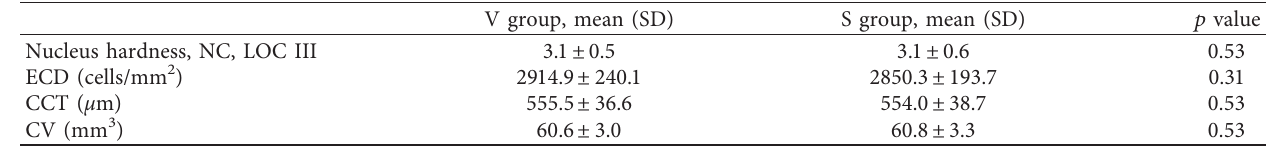
Table 1: Preoperative evaluations.